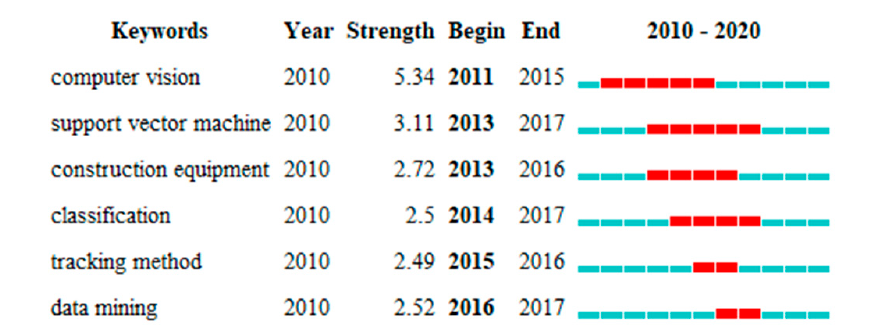
Figure 2. Strong citation burst keywords.